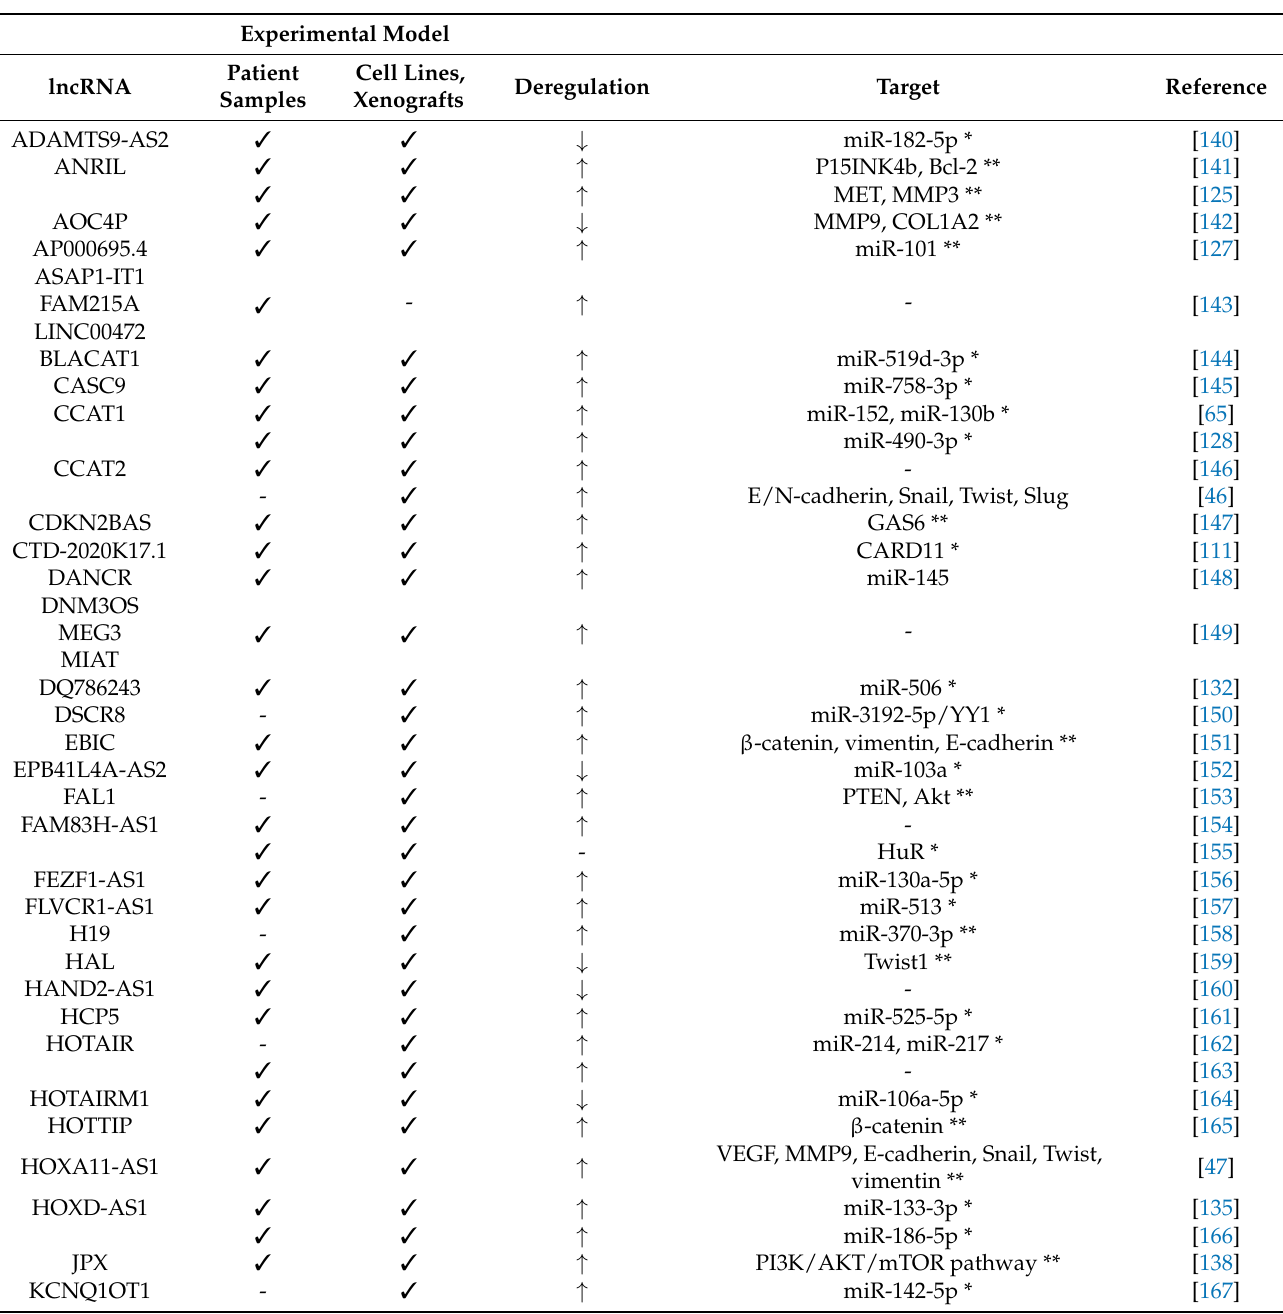
Table 2. lncRNAs and their implication in ovarian cancer